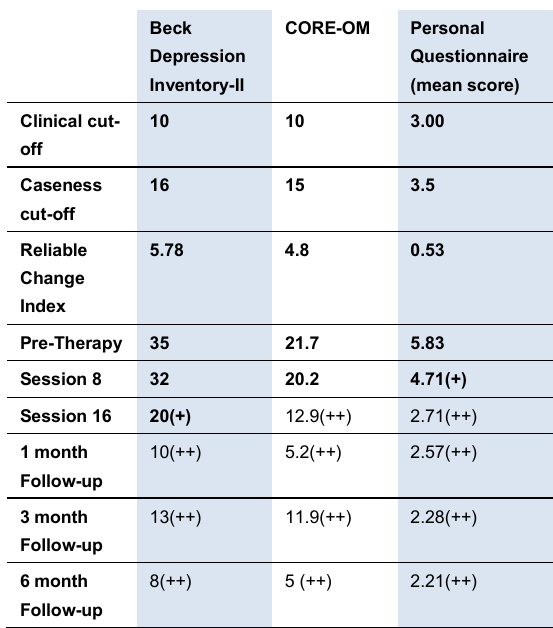
Table B5: Updated Summary of Outcome